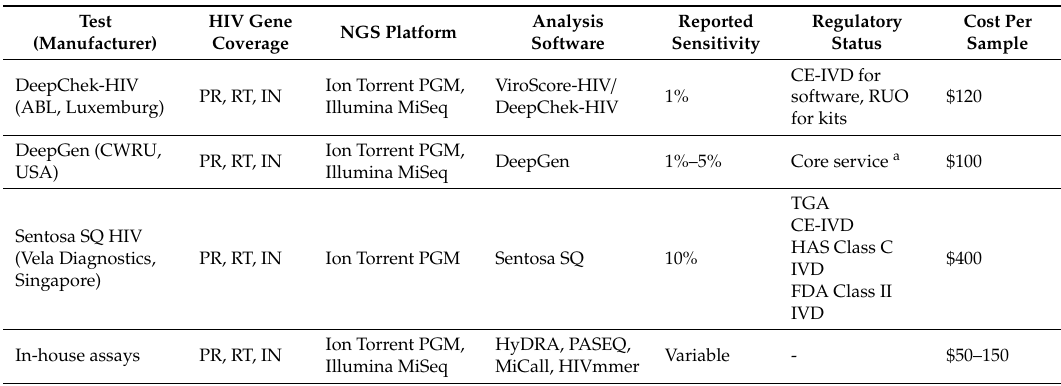
Figure 1. General steps of the NGS workflow for HIVDR genotyping. Common steps for most of the second-generation NGS workflows are shown, including the main sources of variation and possible bias associated with each step. NGS—next generation sequencing; PBMC—peripheral blood mononuclear cells; DBS—dried blood spots; PCR—polymerase chain reaction; QC—quality control; QA—quality assurance; HIVDR—HIV drug resistance. Table 1. Comparison between commercially available NGS-based solutions for HIVDR genotyping and in house-developed protocols.